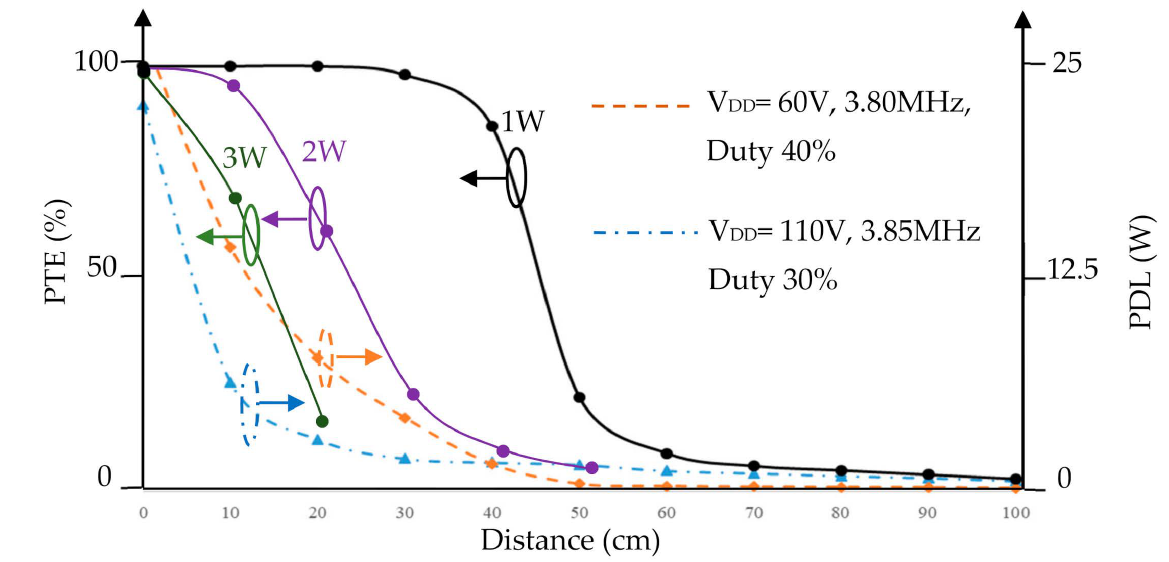
Figure 14. Power transfer efficiency and PDL versus the distance between PTU and